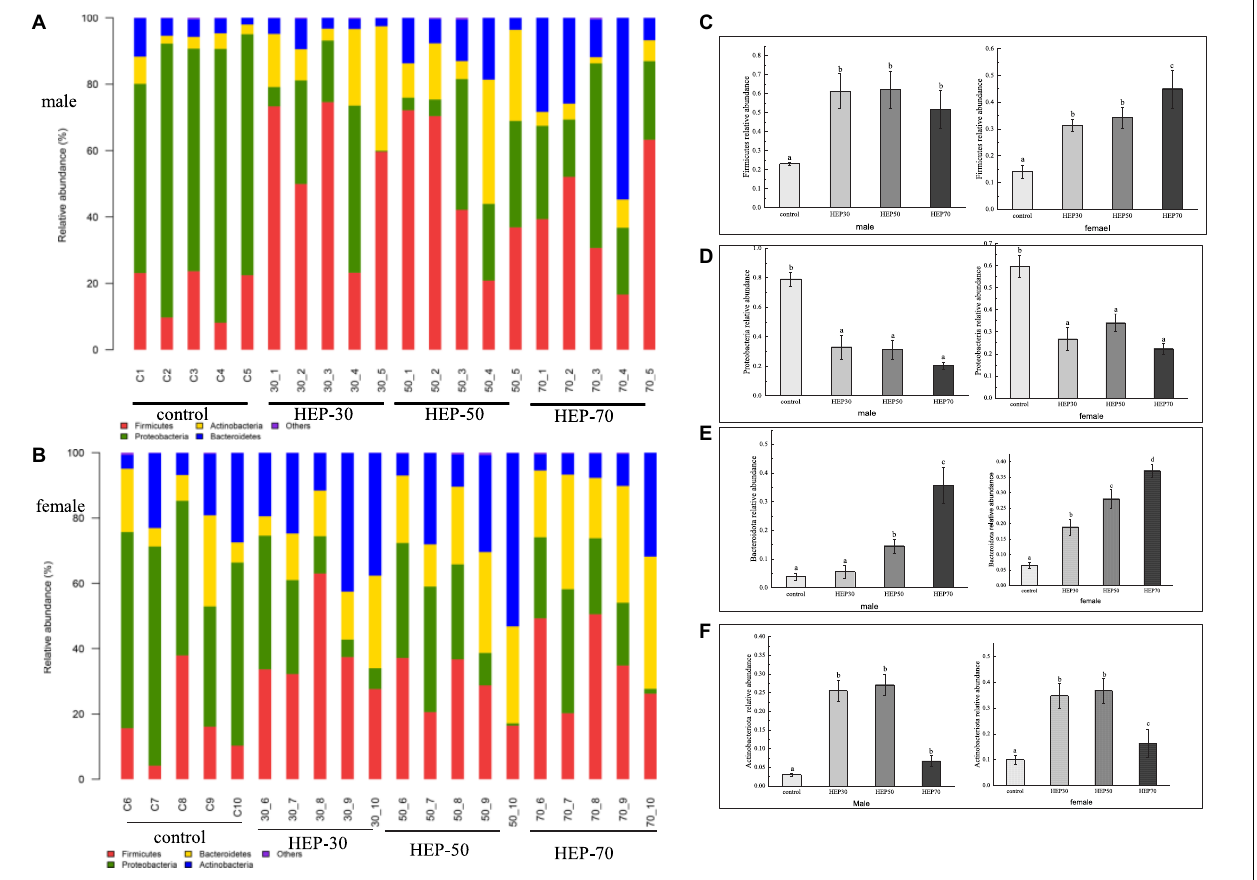
FIGURE 7 | The relative abundance of gut microbiota community at the phylum level in vitro fermentation. (A) , male; (B) , female; (C) , Firmicutes; (D) , Proteobacteria; (E) , Bacteroidetes; (F) , Actinobacteria. Data are means ± SD (5 independent experiments). a , b , c Different letters indicated a significant difference between the two groups ( p <